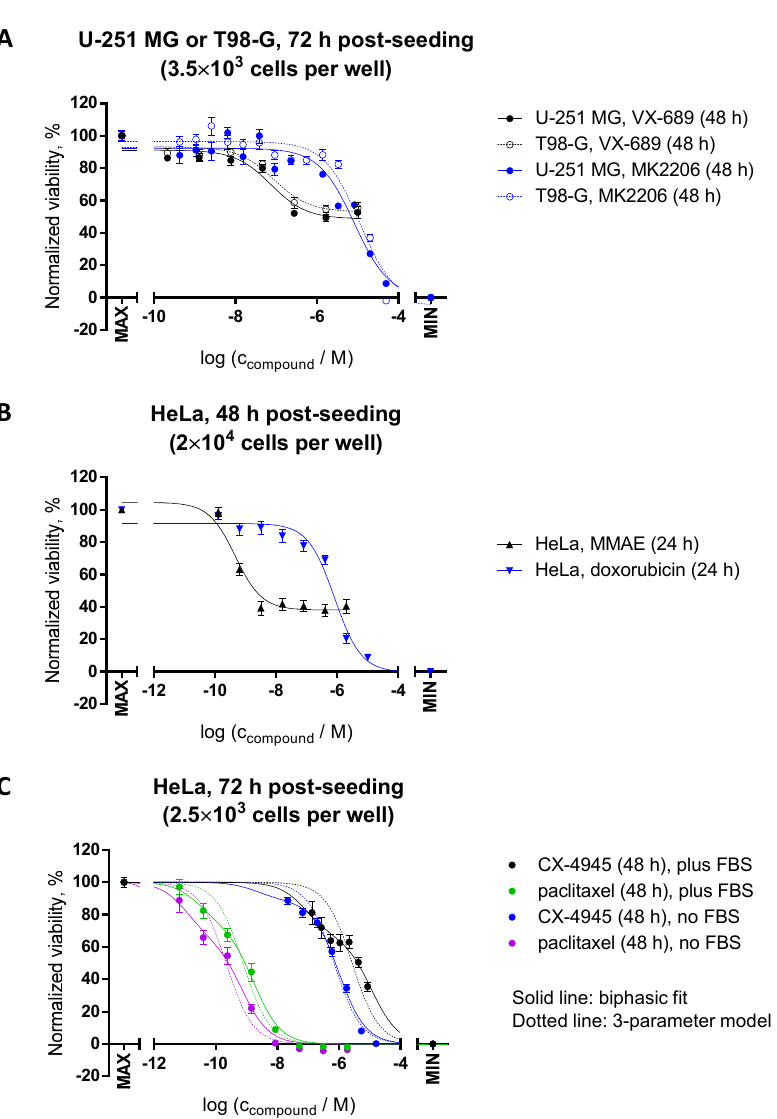
Figure 8. Resazurin assay for the assessment of cytotoxic and cytostatic effects of kinase inhibitors and chemotherapy agents. Glioblastoma ( A ) or HeLa ( B , C ) cells were treated with compounds for indicated duration (see legends on the right-hand side of the graphs) prior to measurement of viability (at 48 h or 72 h post-seeding). Measurements were carried out at 50 µ M resazurin (incubation times with resazurin: within the linear range of the assay). In each graph, the average of duplicates ± SEM from at least two independent experiments is shown. Both fluorescence intensity (excitation at 540 nm) and absorbance ratio (570 nm/600 nm) were detected; for each independent experiment, the data were normalized separately for both optical characteristics and then pooled. For normalization, the following controls were used (MAX corresponds to 100% viability and MIN to 0% viability): ( A , C ) MAX = non-treated cells, MIN = well without cells; ( B ) MAX = treatment with 0.1% DMSO and MIN = treatment with 10% DMSO. For ( C ), the data were normalized separately for the cells grown in the presence or in the absence of FBS. The curves were fitted to the three-parameter logarithmic equations in the case of A and B (no additional restrictions were imposed during fitting), and to the biphasic (solid lines) or three-parameter logarithmic (dotted lines) equations for C (the top and bottom plateaus were fixed to 100% and 0%, and the Hill slope values to − 1).